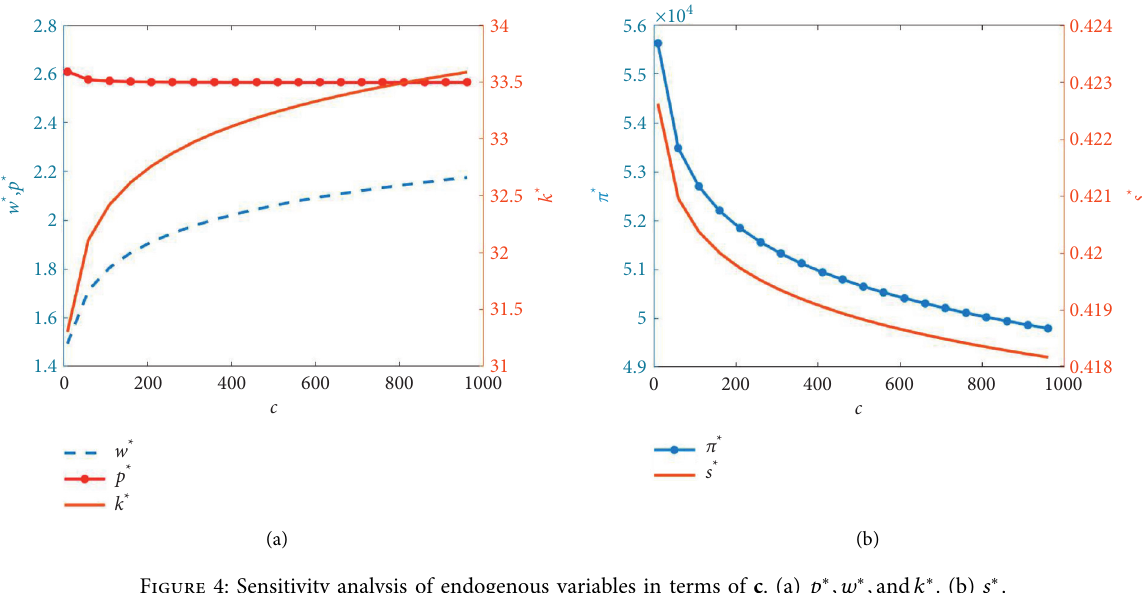
Figure 4: Sensitivity analysis of endogenous variables in terms of c . (a) p ∗ , w ∗ , and k ∗ . (b) s ∗ .